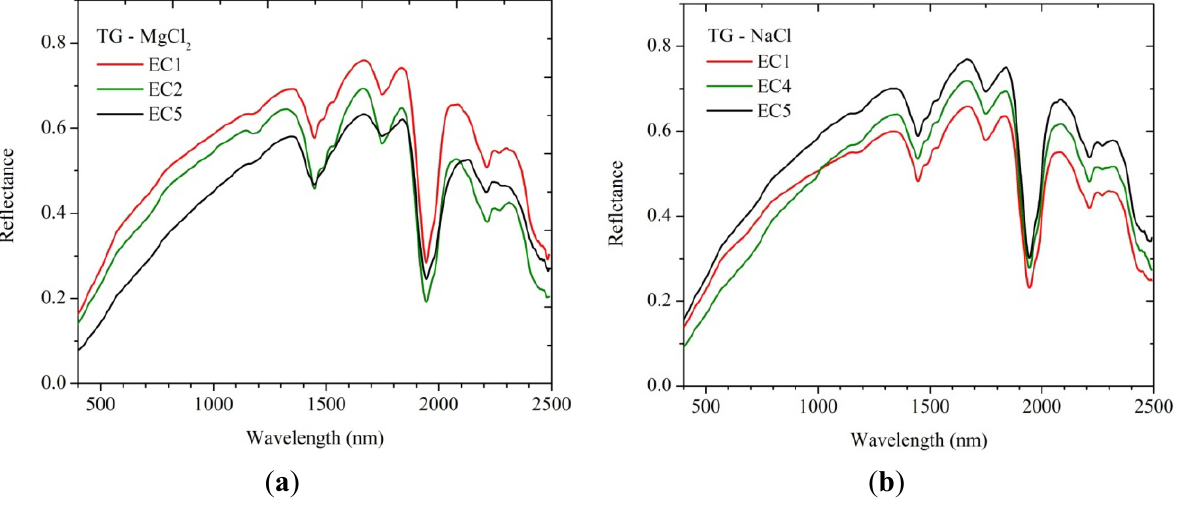
Figure 7. Spectral variation with electrical conductivity (EC) showing higher and lower reflectance values from EC1 to EC5 for ( a ) NaCl and ( b ) MgCl